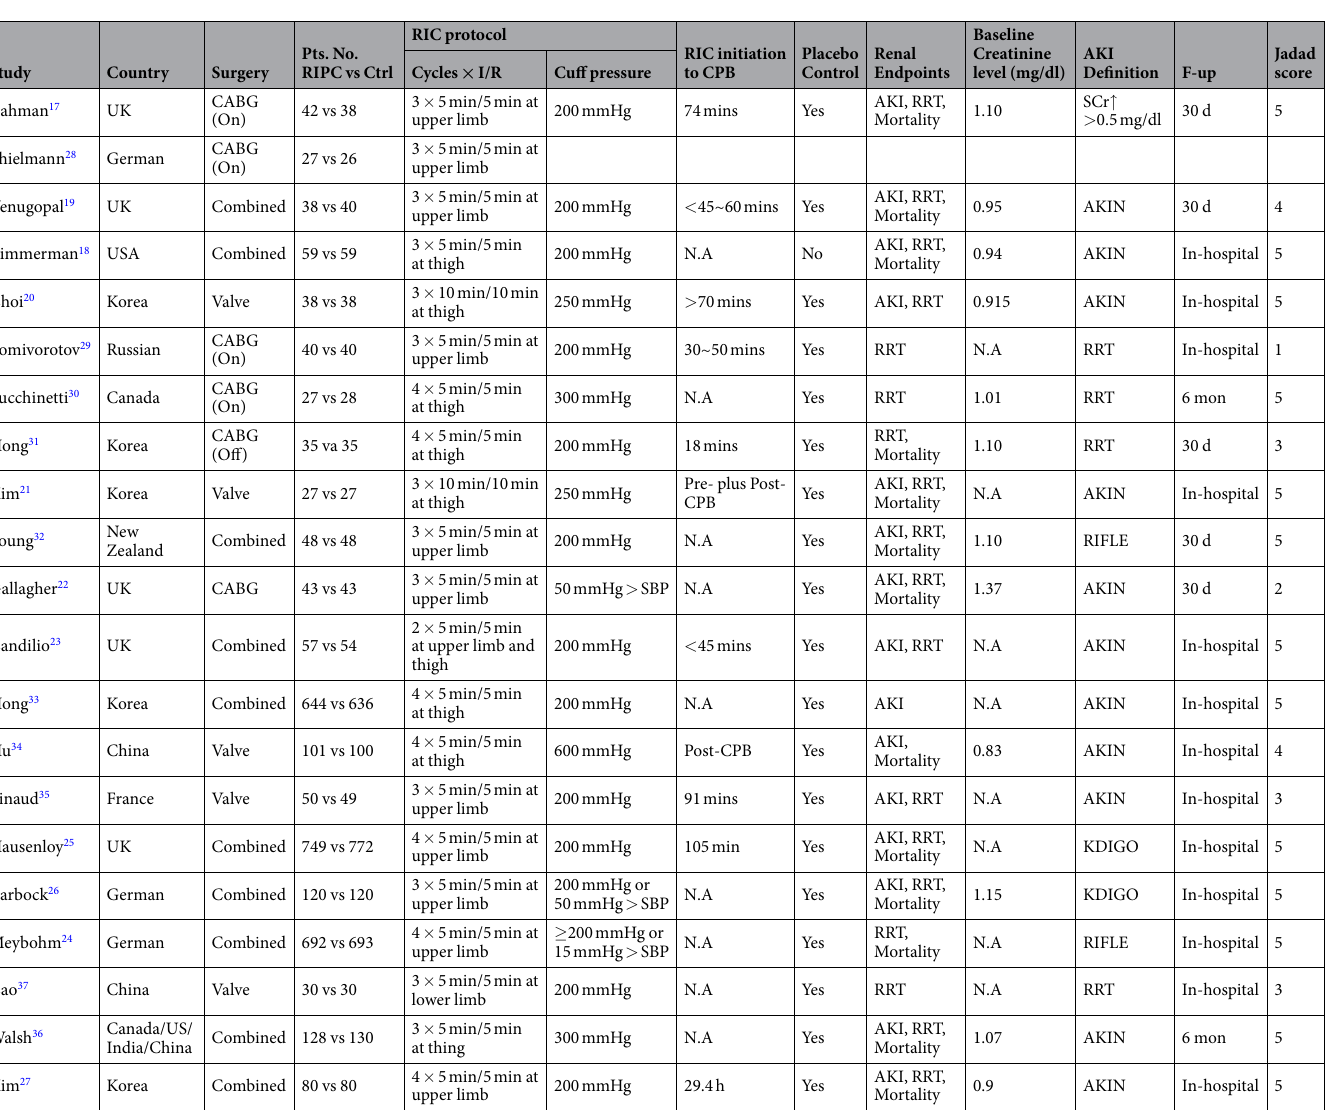
Table 1. Study design in all included RCTs. Note: RCT, randomized controlled trials; CABG, coronary artery bypass graft; I/R, ischemia/reperfusion; SBP, systolic blood pressure; atm, atmosphere; AKI, acute kidney injury; RRT, renal replacement treatment; SCr, serum creatinine; eGFR, estimated glomerular filtration rate; N.A, not available; AKIN, Acute Kidney Injury Network; RIFLE, Risk, Injury, Failure, Loss of renal function and End-stage renal disease; KDIGO, Kidney Disease: Improving Global Outcomes; RIPC, remote ischemic preconditioning; Ctrl,